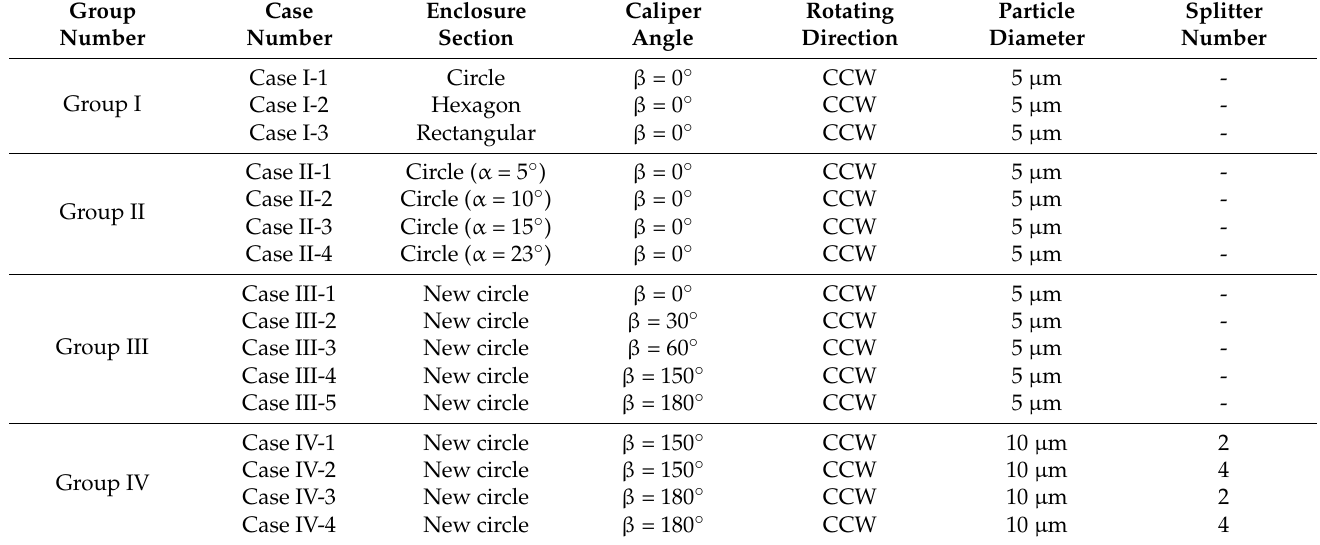
Table 1. Simulation design parameters.